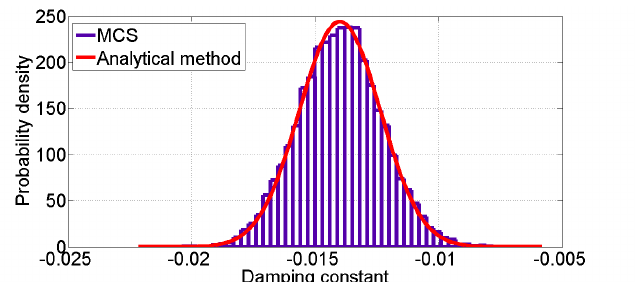
Figure 12. Damping constant of most critical eigenvalue.